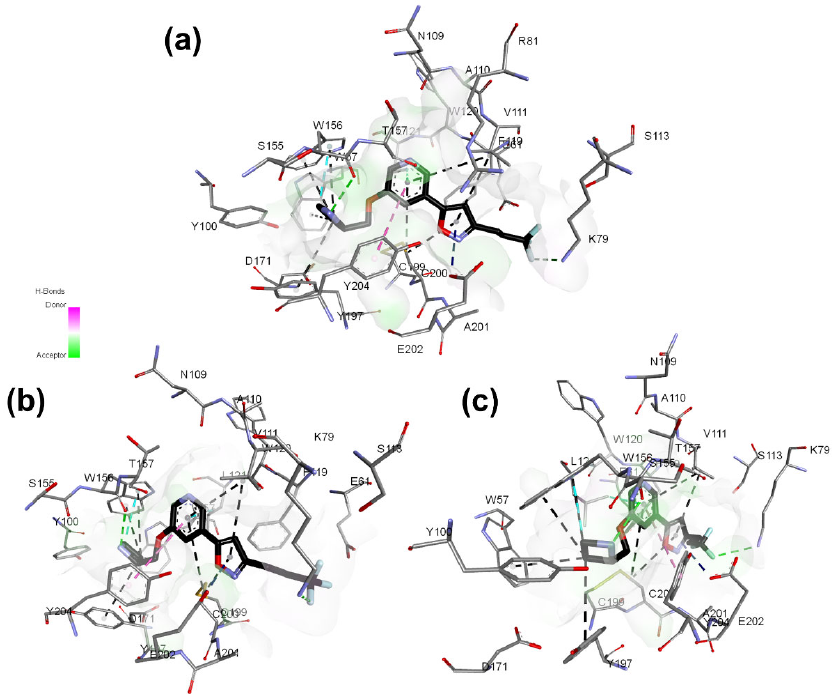
Figure 6. Best docking pose of 13 and hydrogen bond potential surface of ( α 4) 2 ( β 2) 3 receptor binding pocket. (a ‐ c) correspond to different site views. Table 3. Docking conditions and statistics for the 10 best dbCICA models for α 7 receptor.